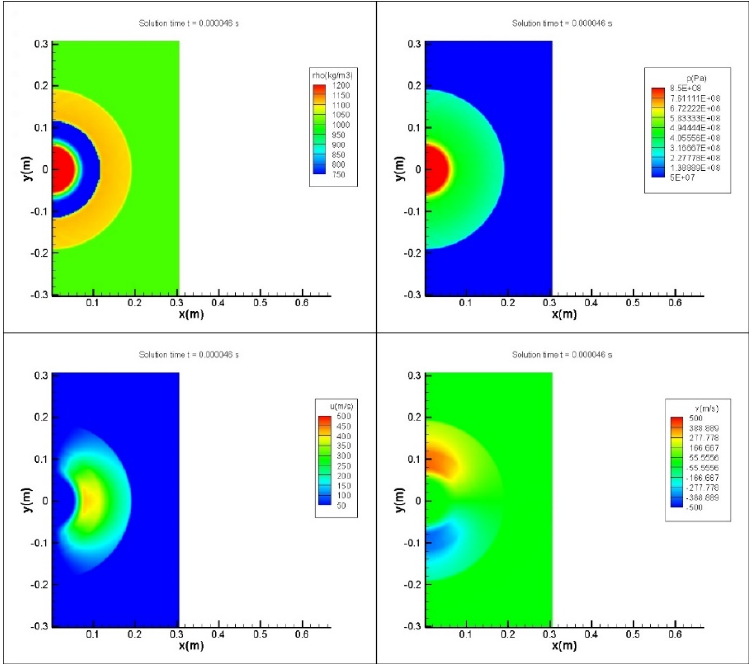
Figure 19. Solution at 4.55 × 10 − 5 s using a 2D axi-symmetric third-order solver ( top left : density; top right : pressure; bottom : velocities in the x and y directions from left to right ).